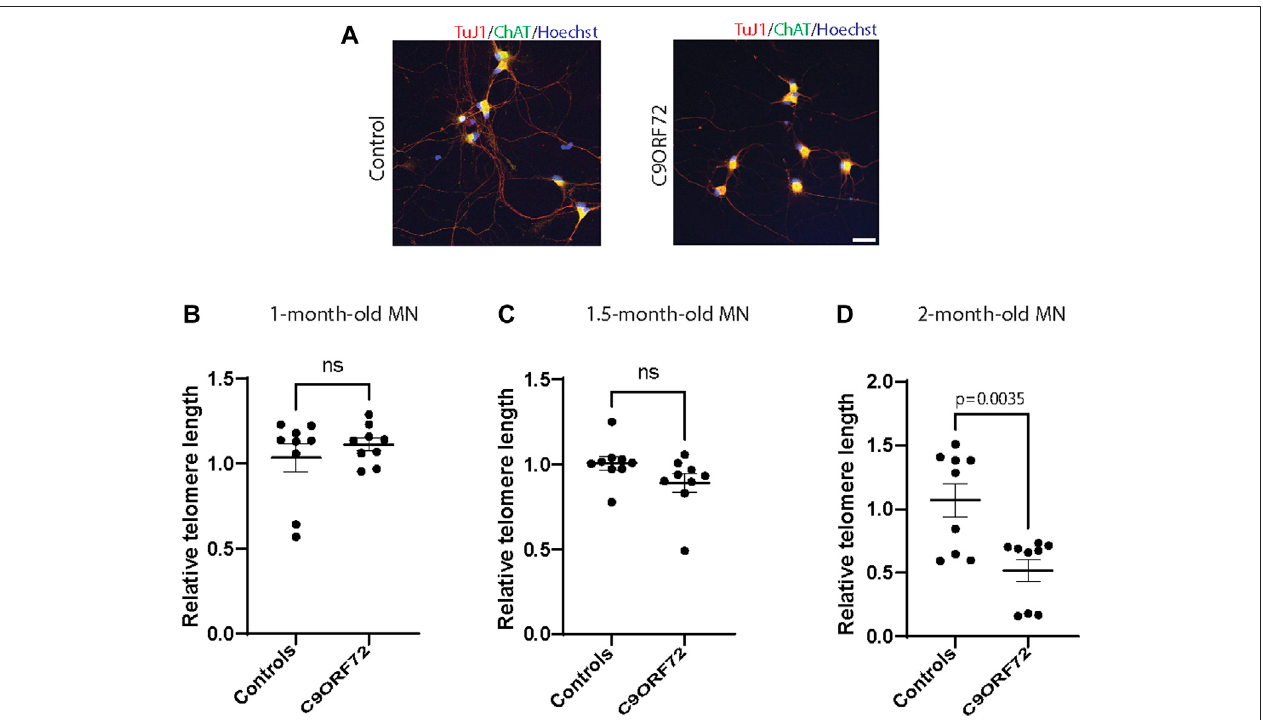
FIGURE 3 | Age-dependent telomere attrition in MNs from C9ORF72 repeat expansion carriers. (A) Representative images from control and C9ORF72 iPCS- derivedMNcultures.qPCRanalysesoftelomerelengthquanti fi cationinpostmitoticMNsat (B) 1, (C) 1.5,and (D) 2 months.Aone-wayANOVAwasappliedtocompare MNs at 1 month, 1.5 months, and 2 months, from 3 controls and 3 C9ORF72 iPSC lines. ns, not signi fi cant. Scale bar = 20 µm.